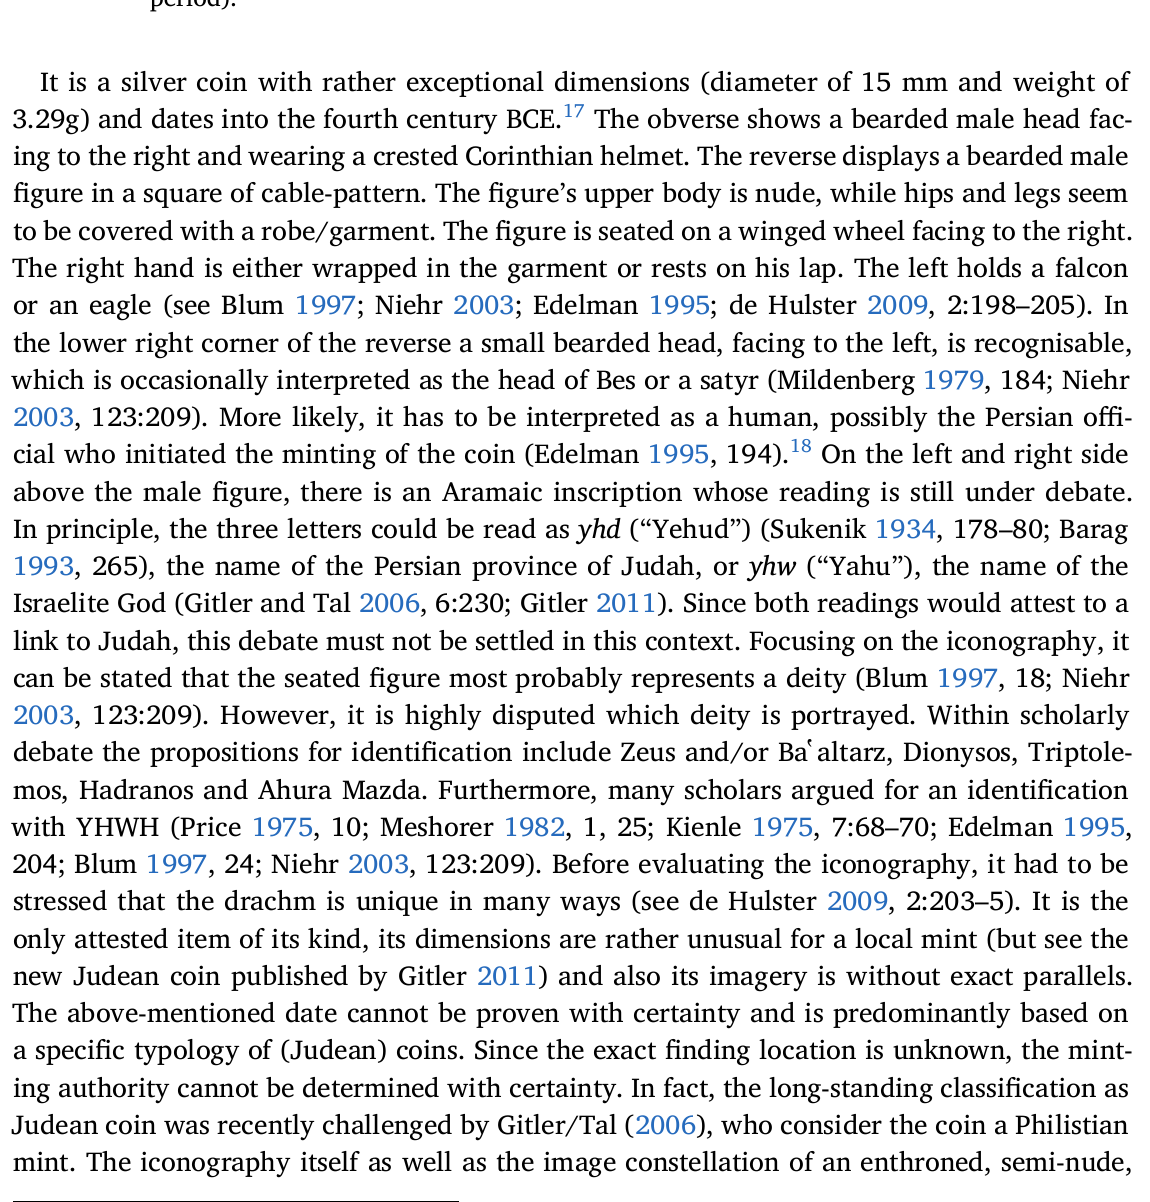
Figure 12 Silver drachm showing an enthroned deity on a winged wheel (location unknown, Persian